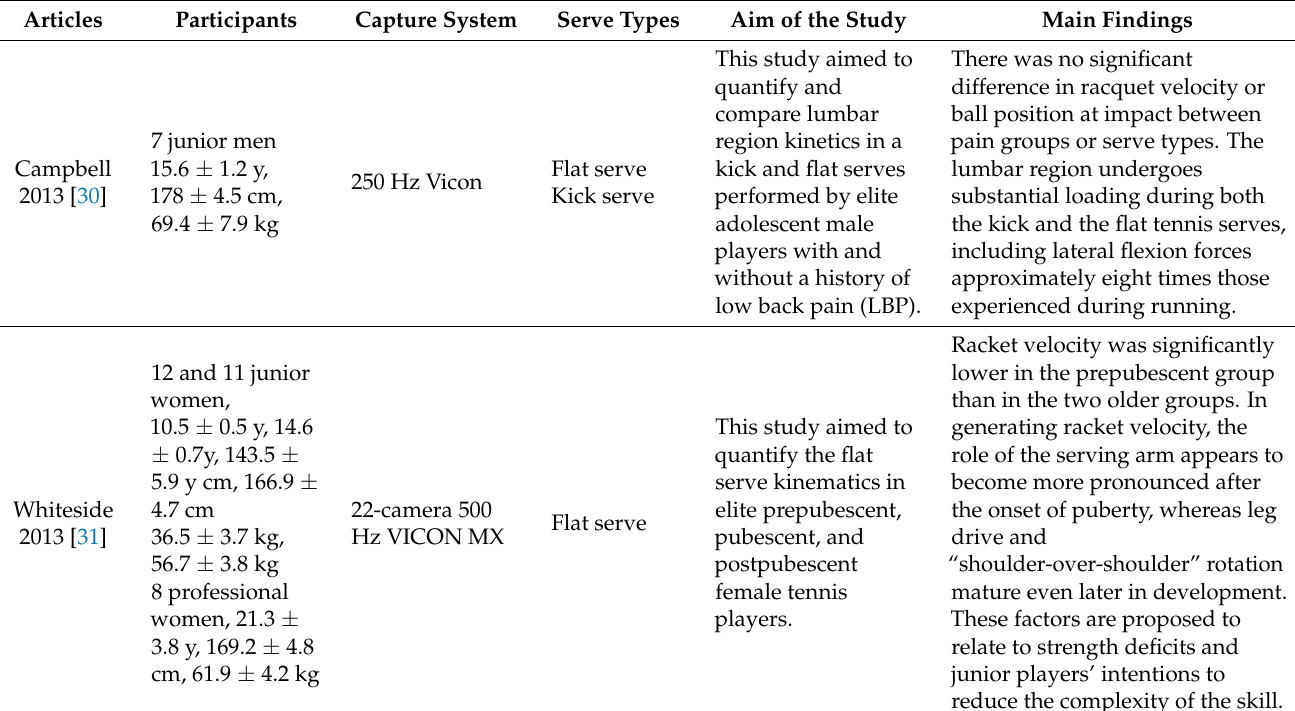
Table 2. The mean and standard deviation of the distance ball impact location from the origin within the tennis serve.